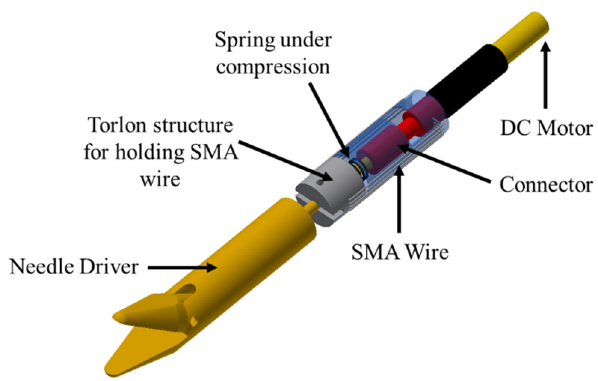
Figure 12. SMA wire-based end-effector for minimally invasive surgery [91].